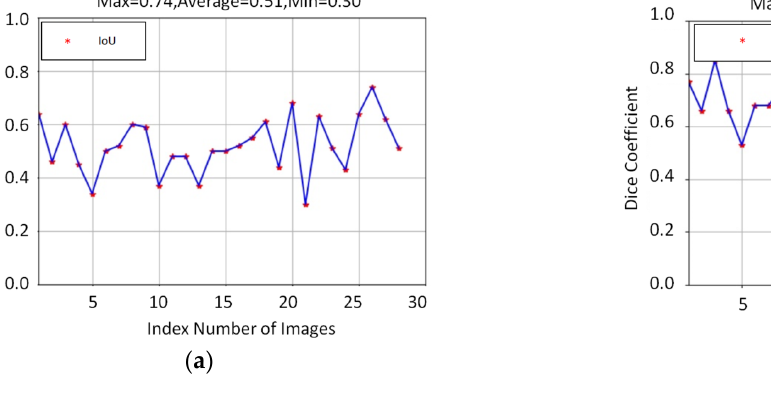
Figure 3. The IoU and Dice Coefficient for ResUnet model.